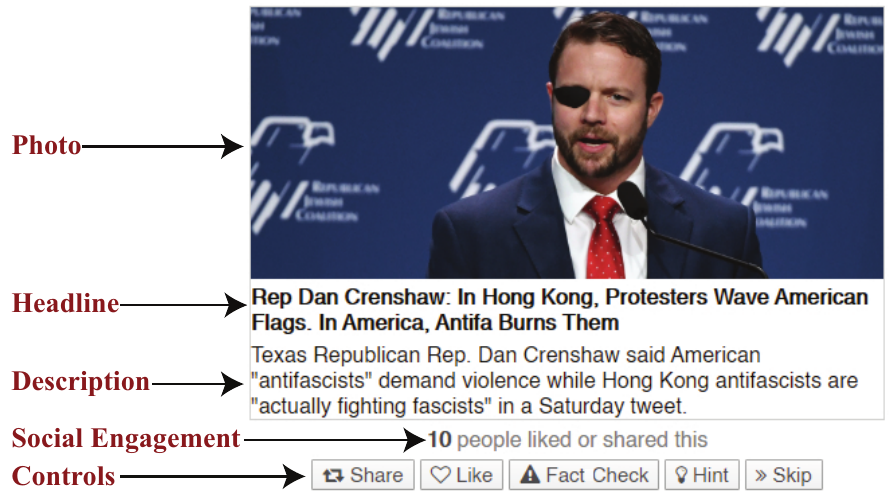
Figure 1: A news post in the social media feed simulated by the Fakey